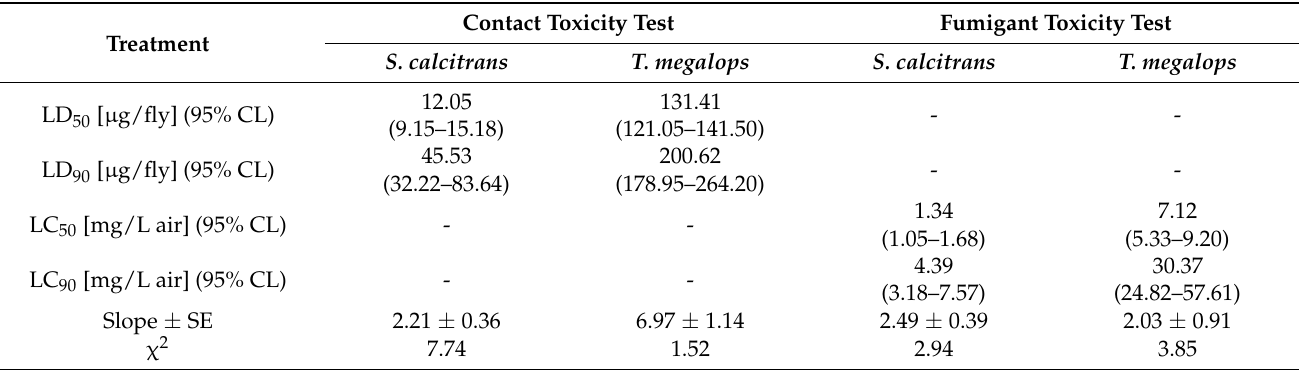
Table 3. Lethal dose (LD 50 and LD 90 ) and lethal concentration (LC 50 and LC 90 ) of Plectranthus amboinicus essential oil against Stomoxys calcitrans and Tabanus megalops by contact and fumigant toxicity tests at 24 h after treatment.